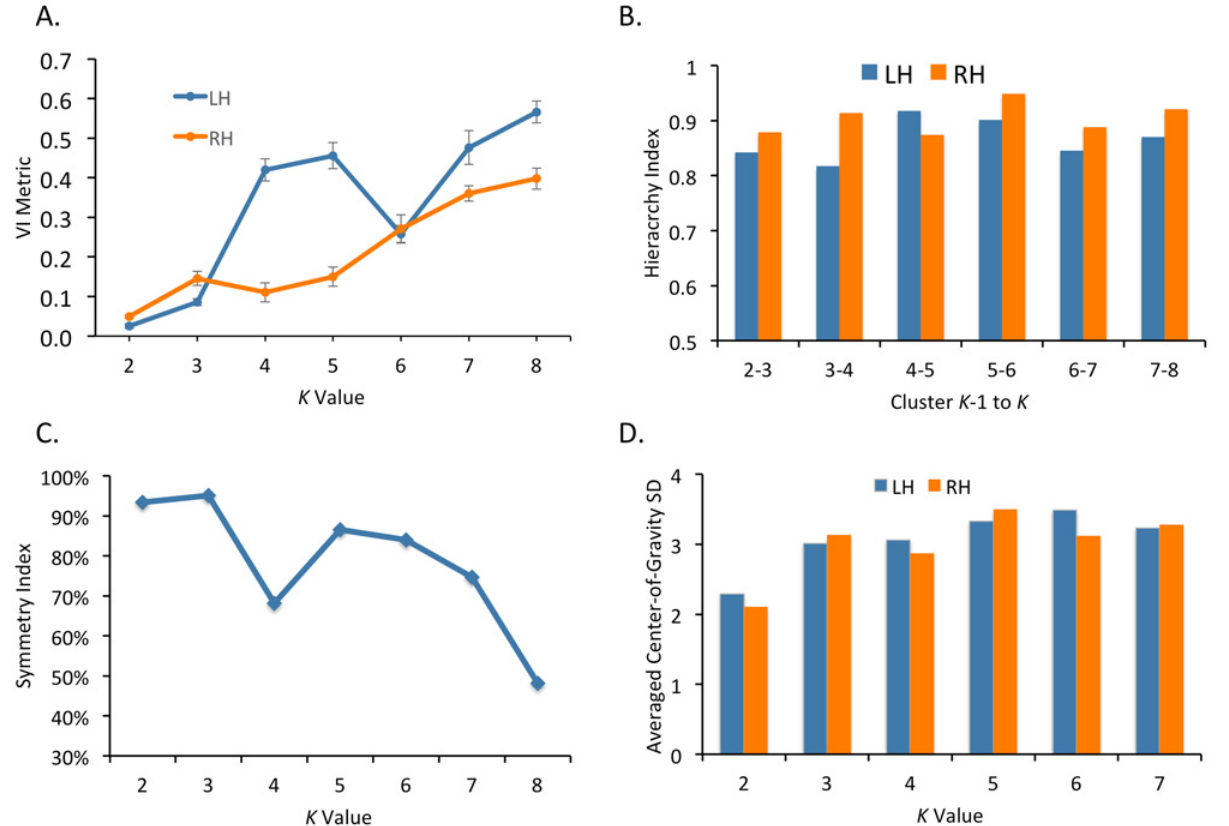
Fig 1. Cluster metrics. A) Variation of information metric for each K value and each hemisphere. Error bars represent 95% confidence intervals. B) Hierarchy index for each K value and each hemisphere. C) Symmetry measurement between the left and right hemispheres for each K value. D) Average of the standard deviation in the center-of-gravity across clusters for each K value.